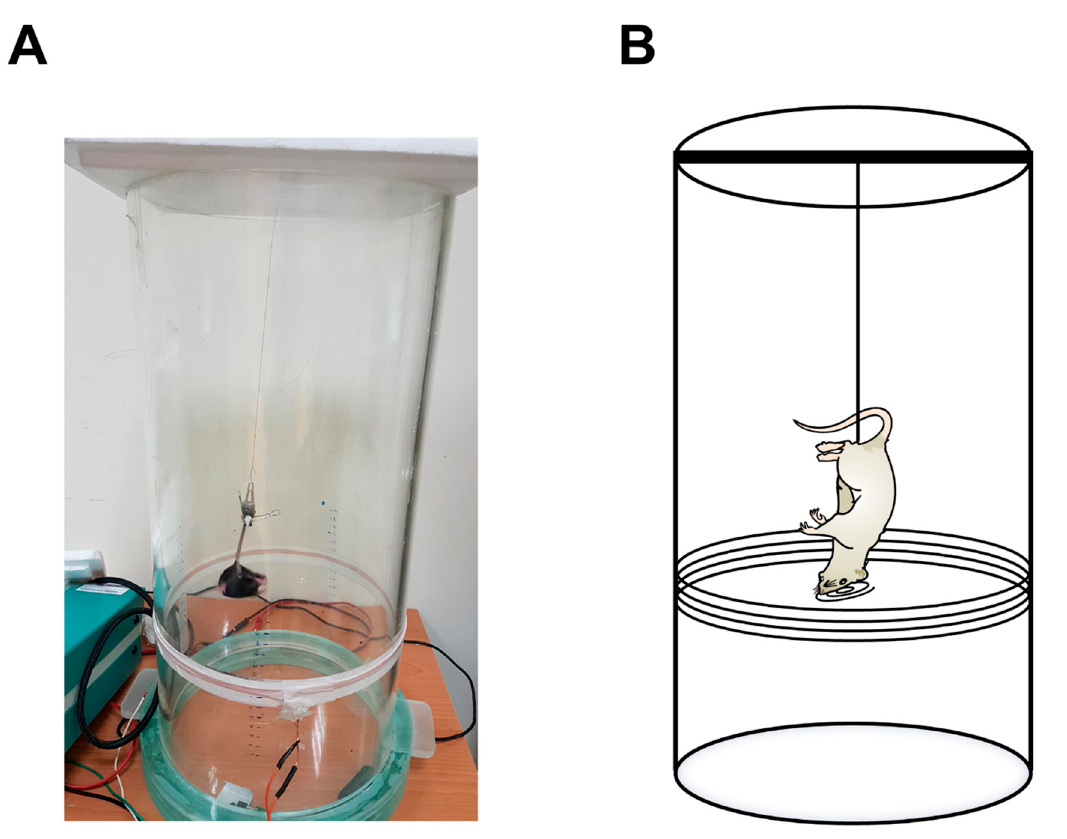
Figure 10. Depression test in the tail suspension task with optogenetic photostimulation. ( A ) The wireless remote-controlled device was applied in the tail suspension task. To test depression behavior in the tail suspension test, the optical fiber was implanted into the medial prefrontal cortex (mPFC). ( B ) An illustration showing an animal with photostimulation to test depression in the tail suspension task.